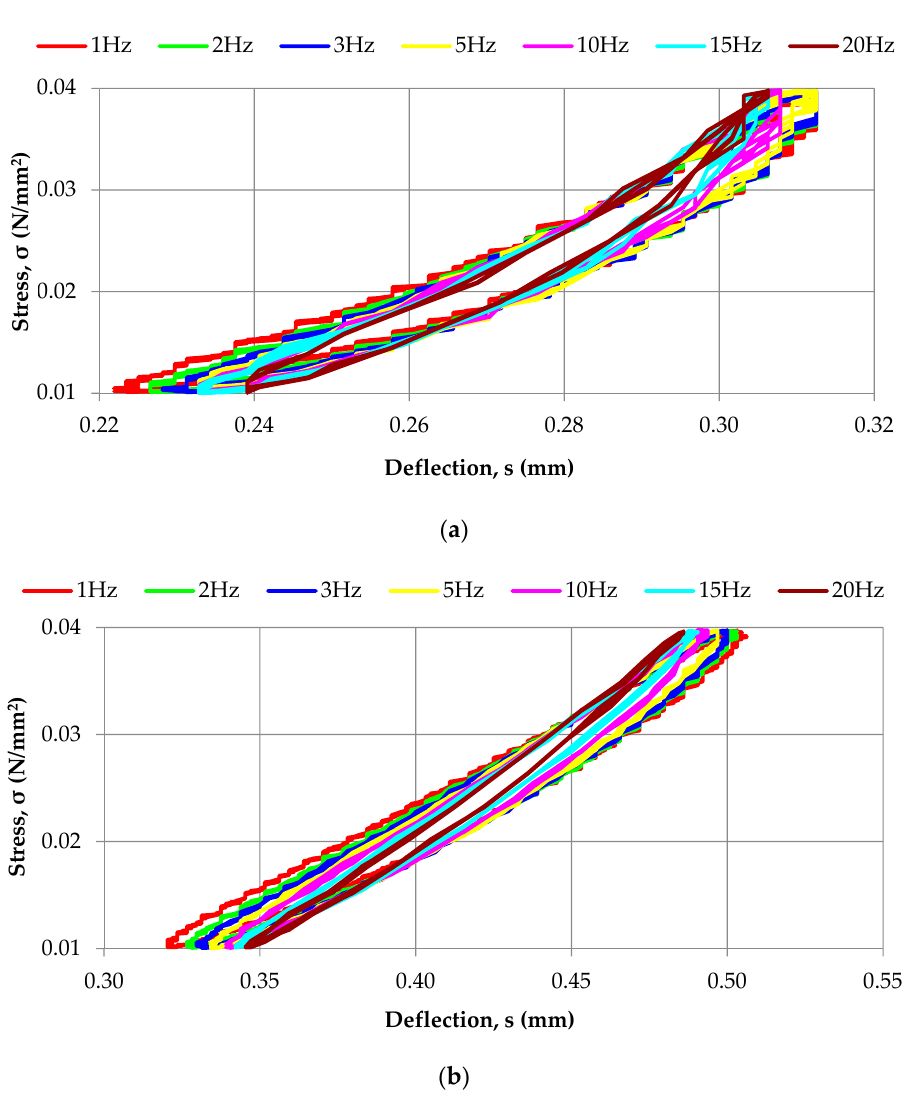
Figure 4. Diagrams of dynamic characteristics of the elastic cover of prototype rail dampers obtained for two extreme densities of SBR granulate: ( a ) 1100 kg/m 3 ; ( b ) 650 kg/m 3 . Table 2. Dynamic bedding moduli of the elastic cover of prototype rail dampers obtained for seven densities of SBR granulate (650–1100 kg/m 3 ) within the applied and assessed loads range of 0.010 ÷ 0.040 N/mm 2 .